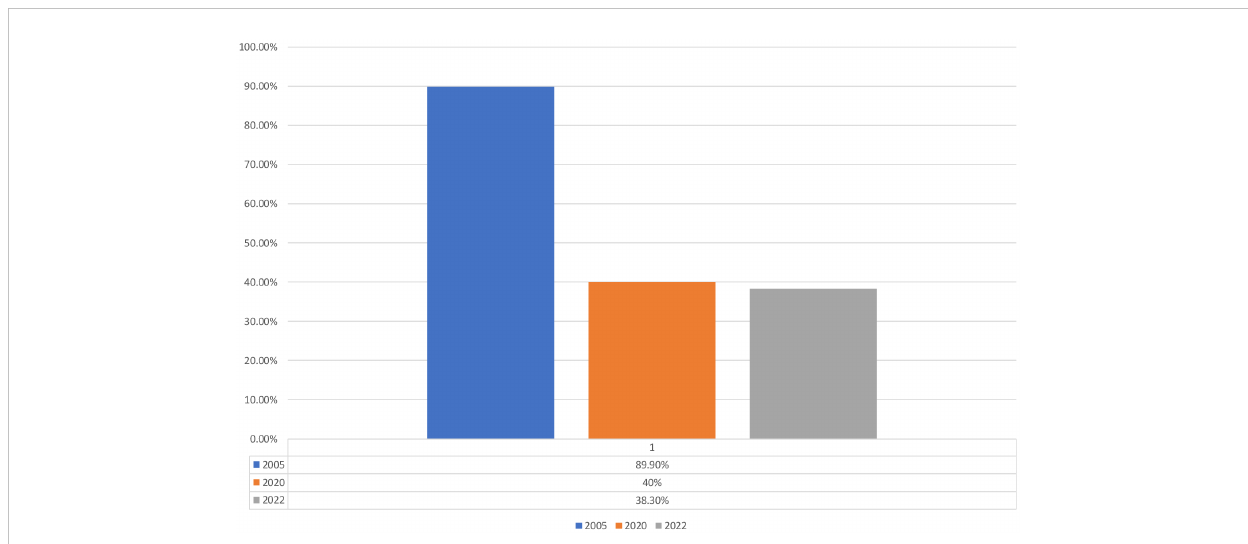
FIGURE 3 Trend of DKA in children and Youth with diabetes in Tanzania [Majaliwa, Edna., et al. “ Diabetes care (2007);30.9: 2187-2192 (28); Kipasika, H., et al. “ Int J Diabetes Clin Res (2020); 7:126, Unpublished